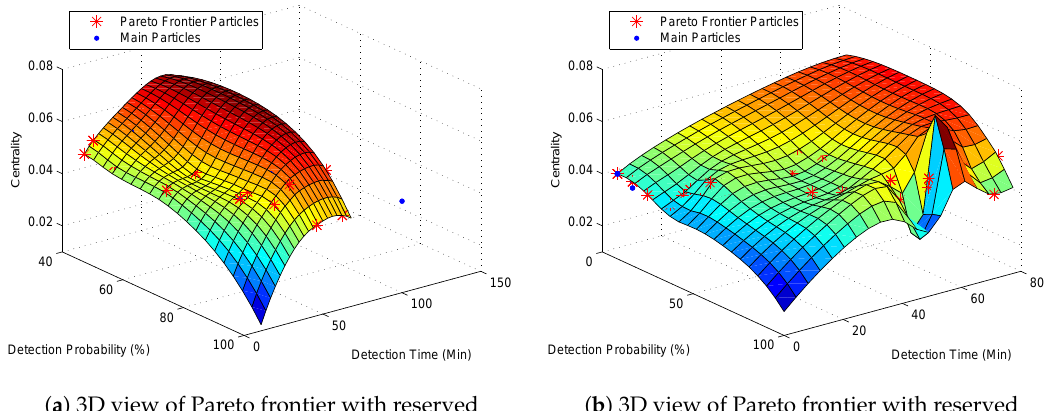
Figure 7. Pareto frontier with four optimization